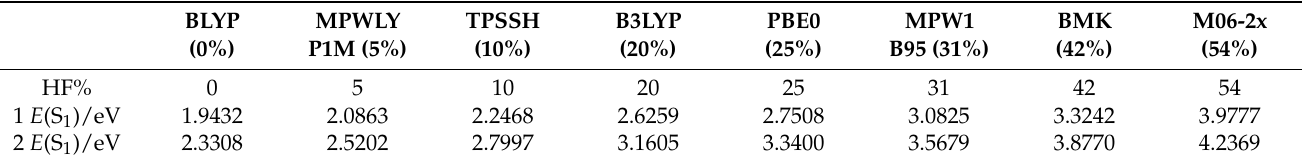
Table 1. Calculated E (S 1 ) using various functionals and LANL2DZ/6–31G(d) basis set in CH 2 Cl 2 media for complex 1 and 2 .